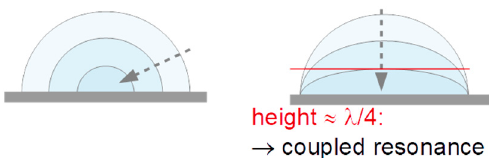
Figure 7. Two modes of droplet drying. On the left-hand side, the three-phase line is free to move,